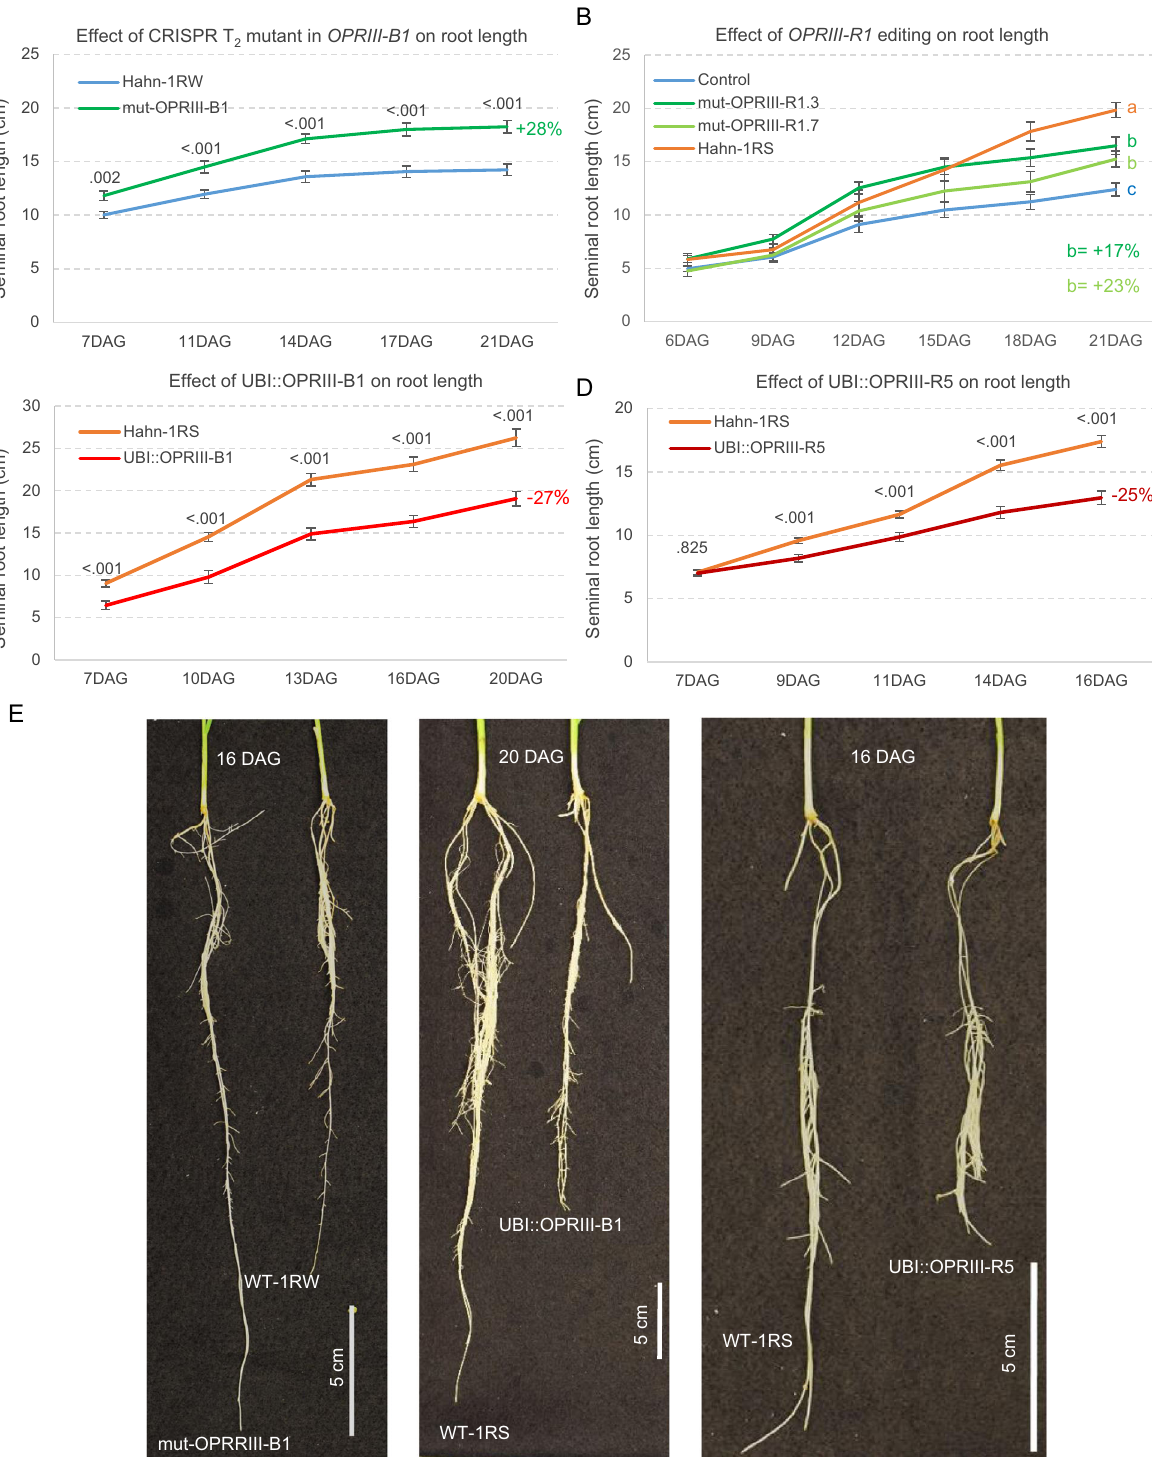
Fig.2|Effectofloss-of-functionmutationsandover-expressionof OPRIII genes onroot length.A Effect of1RWT 2 sister lineswith and without a32-bp deletion in OPRIII-B1 on seminal root length ( n =20 – 22). Exact P values based on two-tailed t testsareindicatedateachtimepoint. B Effectof1RWT 2 lineswithatleastonecopy of a 3-bp ( n =12) or a 7-bp ( n =8) deletions in OPRIII-R1 ( R1.3 and R1.7 ) on root seminal length. Control = combined 1RW parental line and 1RW transgenic sister lines without the deletion ( n =25), 1RS=Hahn-1RS with no OPRIII duplication